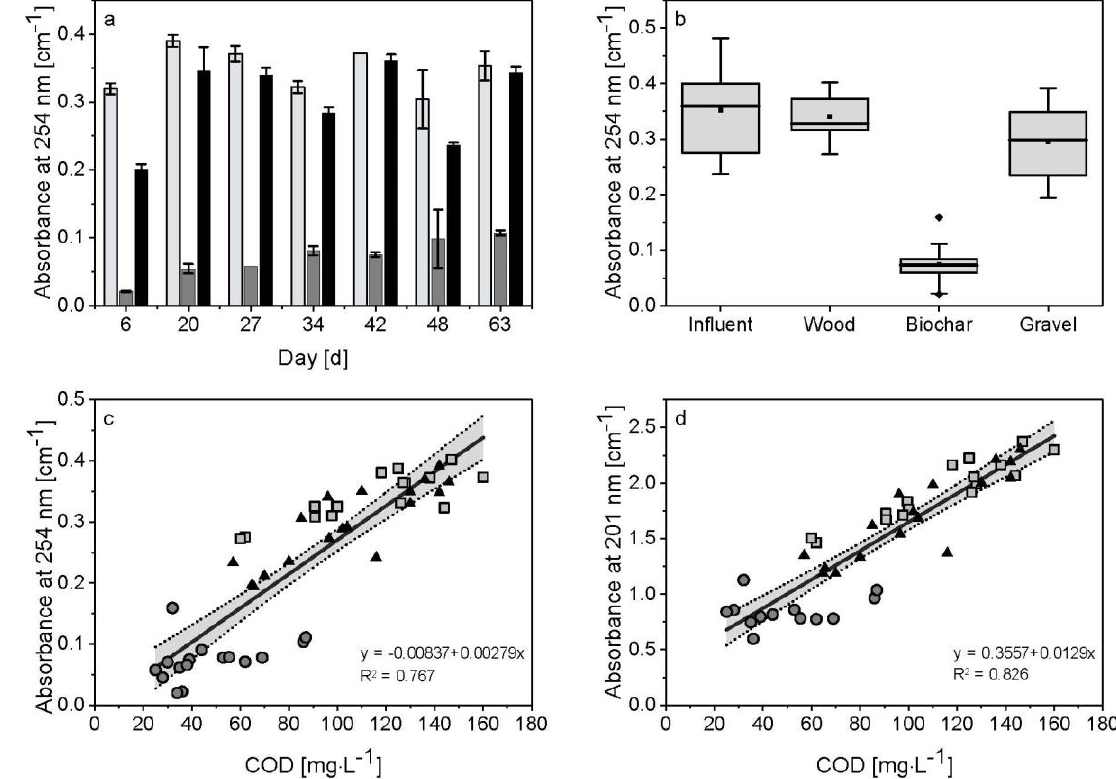
Figure 3. ( a ) Mean UV extinction of filter effluents at 254 nm of gravel (black), biochar (grey), and woodchips (light grey) over time. Error bars represent standard deviation. ( b ) Boxplot of UV absorbance at 254 nm of filter effluent and raw water. Correlation between COD concentration and UV absorbance at ( c ) 201 nm and ( d ) 254 nm of filter effluent of gravel (black triangles), biochar (grey circles), and woodchips (light grey squares) filters. Straight lines are regression lines with 95% confidence zones (grey area between dotted lines).